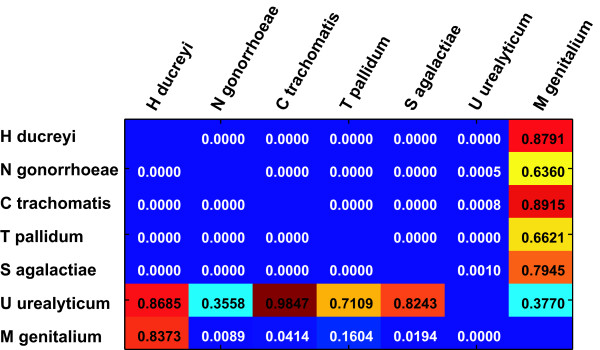
Feature concordance between species. The feature lists selected for function prediction in each species using the Wilcoxon filter as described were analyzed for concordance. The feature selection procedure generates sorted lists of features. The agreement between these lists can be calculated using a rank correlation method, for example Kendall's Coefficient of Concordance. A good correlation (reflected in a small p-value) indicates that the same features are high in the list of selected features. The p-values of Kendall's Coefficient of Concordance for each pairwise comparison are shown. The feature lists for the first five species show high correlation, while those of the two mycoplasmal species differ significantly. This may explain the difference in performance on these two species. Note that the matrix is not symmetrical, because different features will be removed by the redundancy filtering step depending on which species is used as a reference